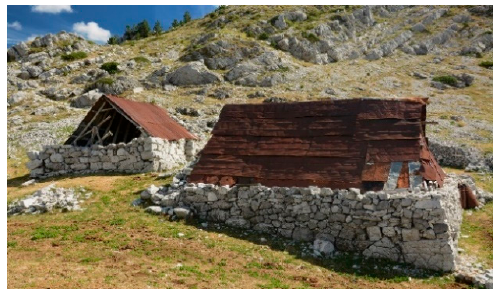
Figure 31. Glada’s roof made of the tin barrels - Koštica, Kotski katun, photo: I. Lakovi ć .